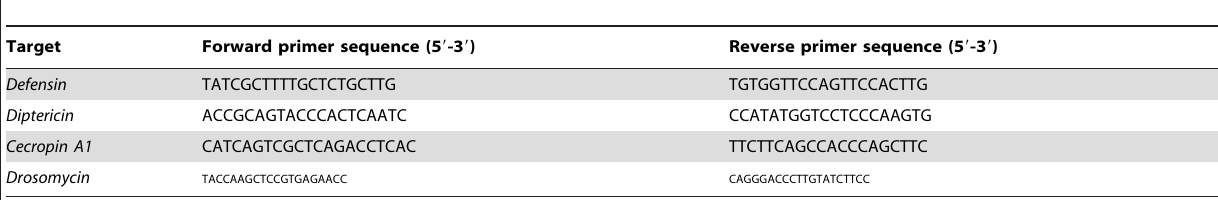
Table 1. Primers used to detect AMPs in real-time quantitative PCR